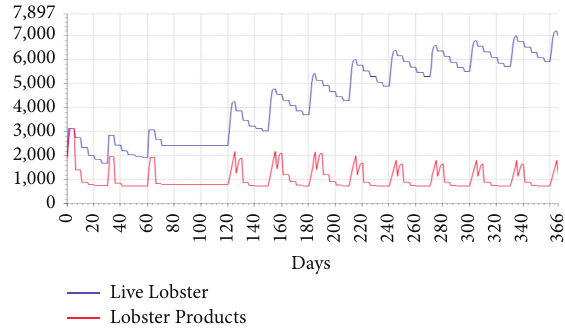
Figure 4: Available inventory including backlog